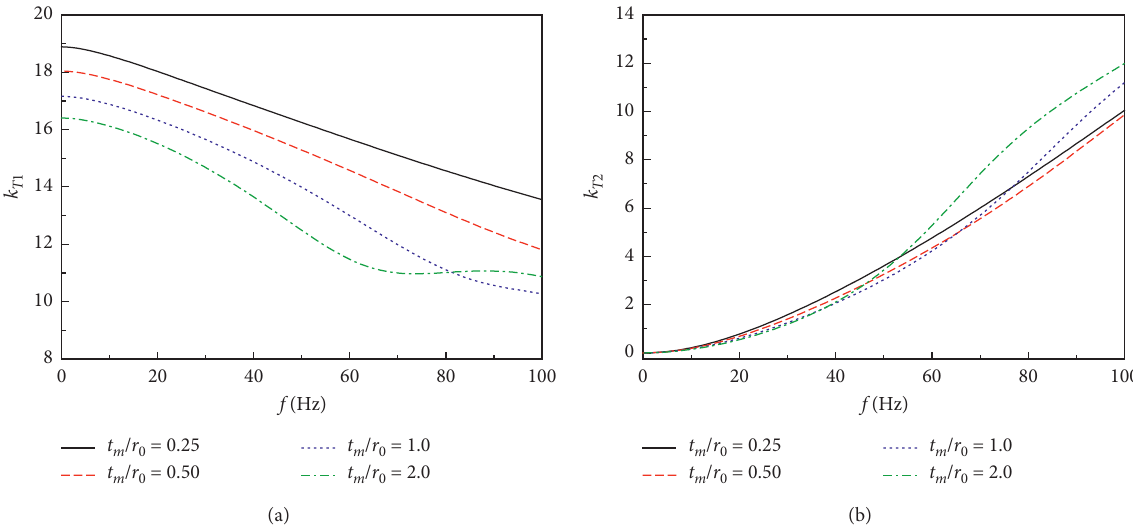
Figure 7: Influence of the disturbance range t GR � 0.5).